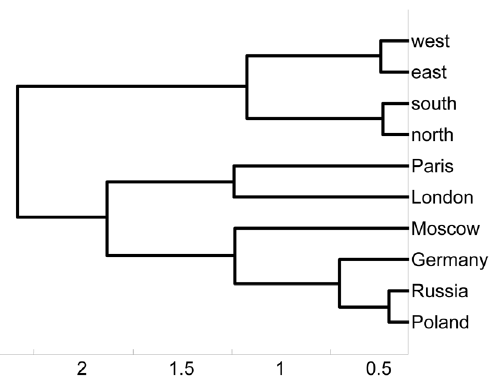
Figure 5. Hierarchical cluster tree computed from the LSA scores of similarity for { London,Moscow,Paris,north,south,east, west,Germany,Poland,Russia } given in Figure 4.